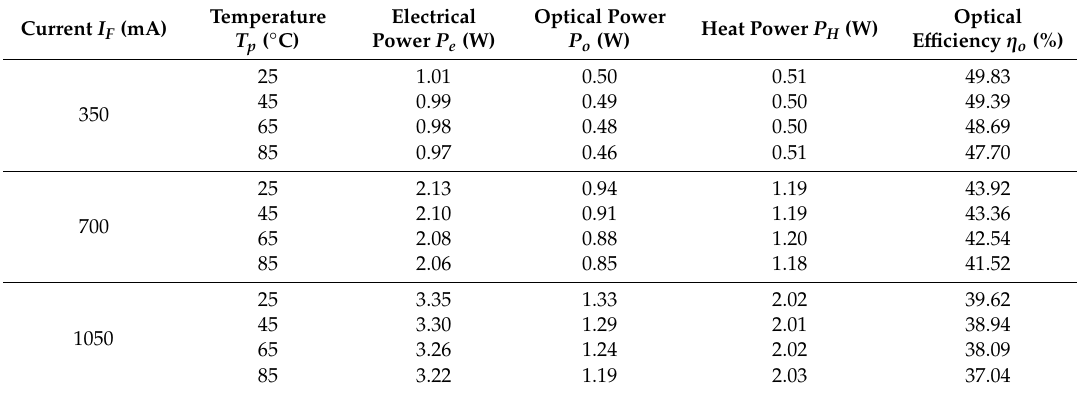
Table 1. Electric power P e , optical power P o , heat power P H and optical e ffi ciency η o for the studied LED